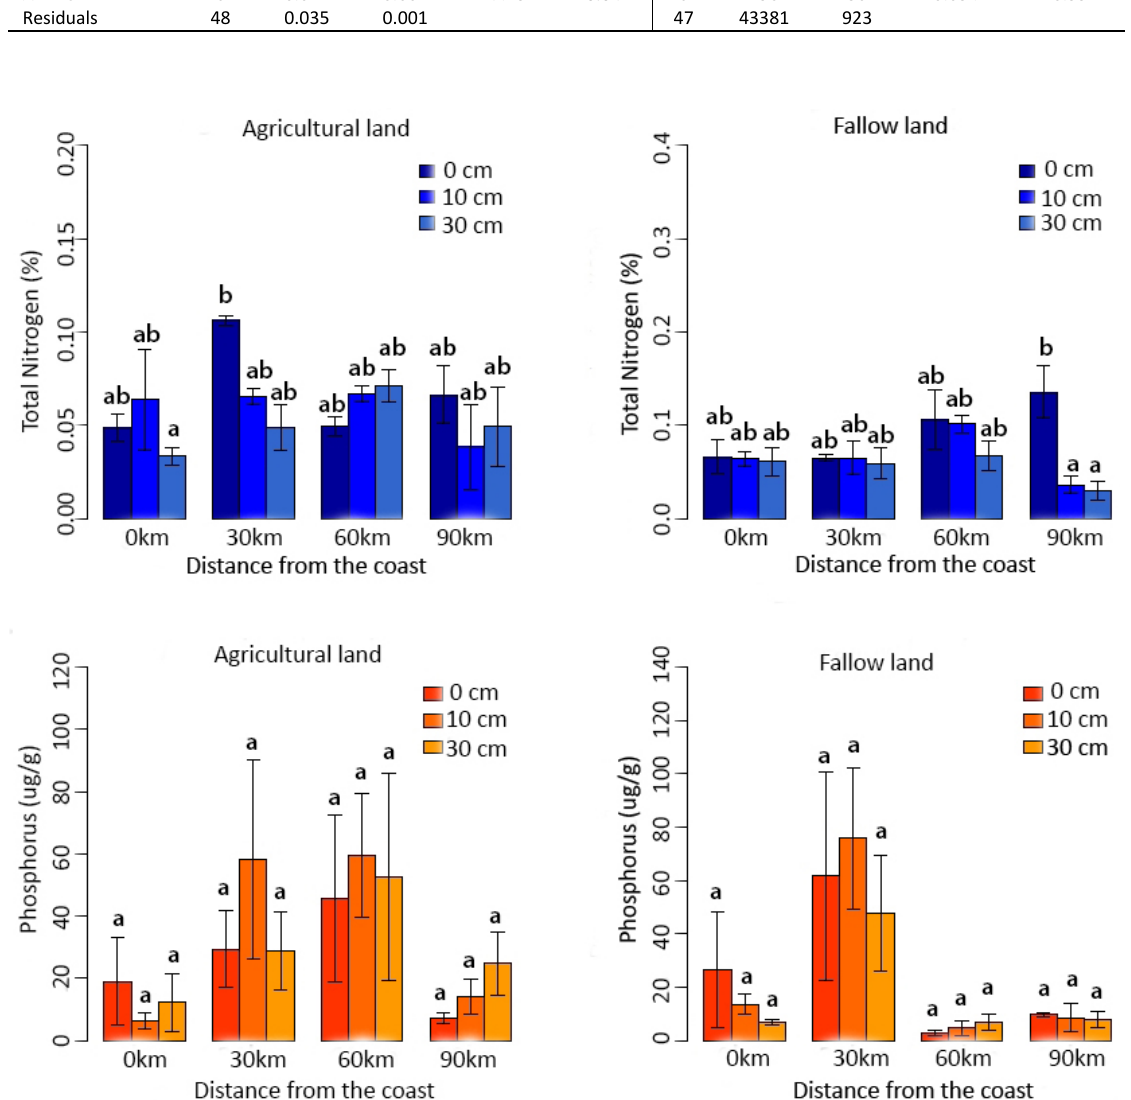
Fig. 5: Bar graphs showing the soil TN (5a) and P (5b) differences along a distance gradient from the coast in different soil depth in both agricultural and fallow land. Different letters above the error bars denote significant differences among the groups based on Tukey's post‐hoc test at α≤0.05 where homogeneous letter subsets are expressing non‐significant difference.